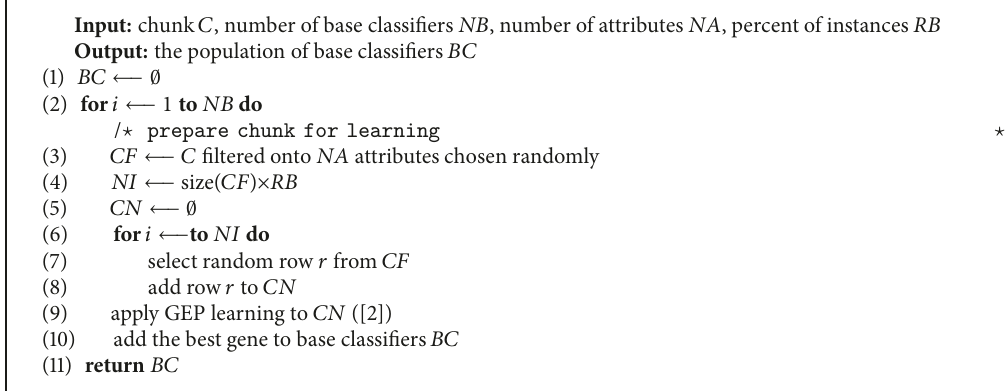
Algorithm 1: Inducing base classifiers.